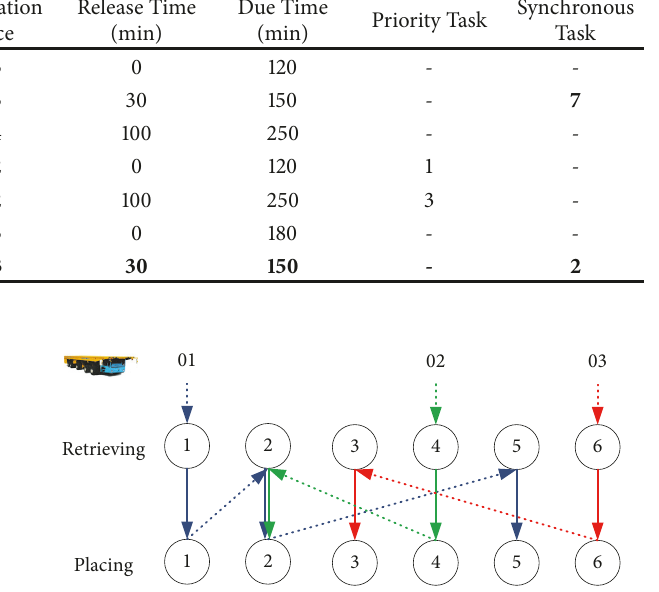
Figure 1: A sequencing and assignment plan for block transporta-